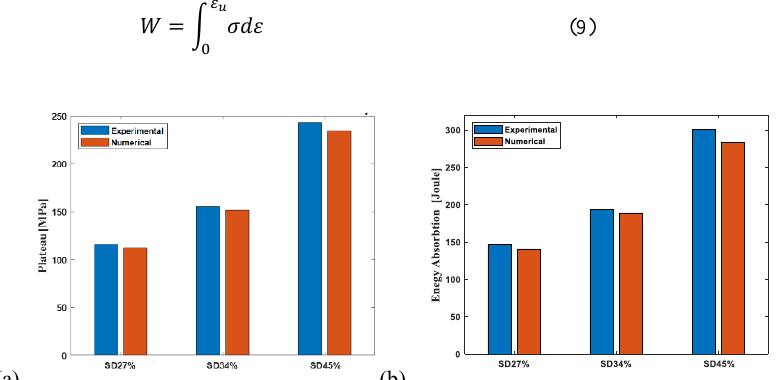
Fig. 9. Numerical and experimental comparison of (a) plateau stress level and (b) impact energy absorbed by SD lattices under dynamic